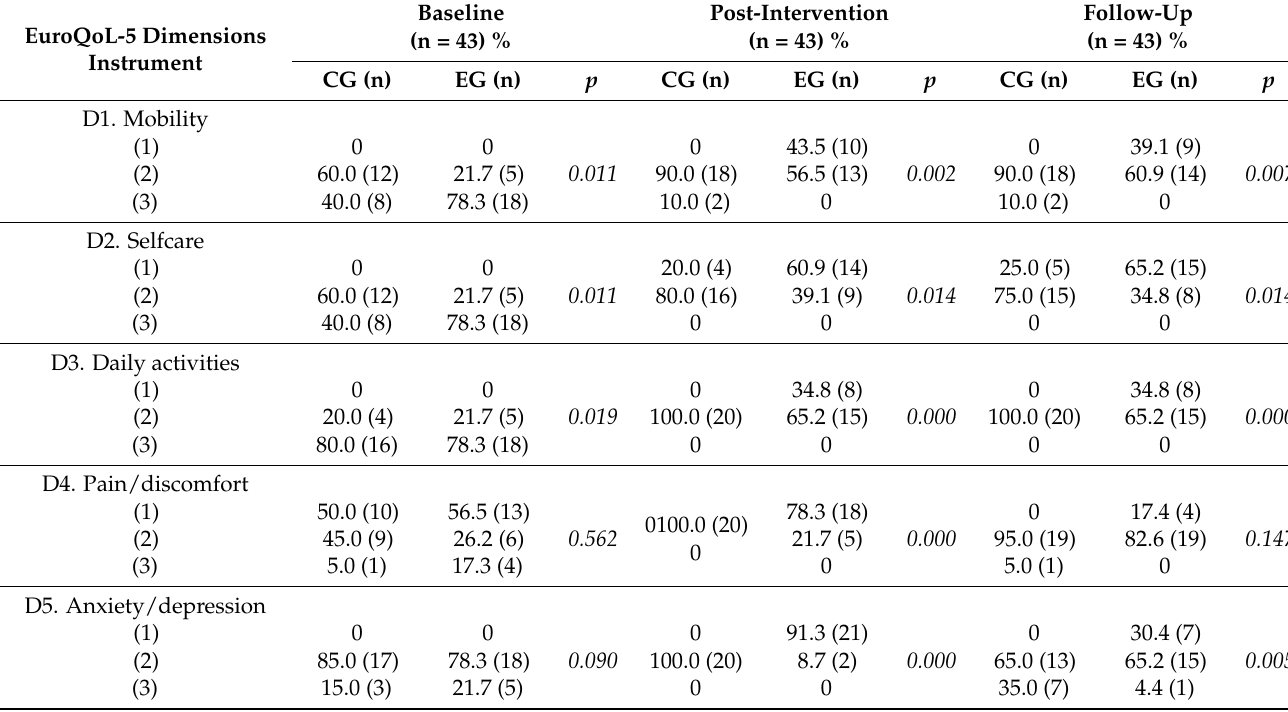
82.6; anxiety: from 8.7 to 65.2).